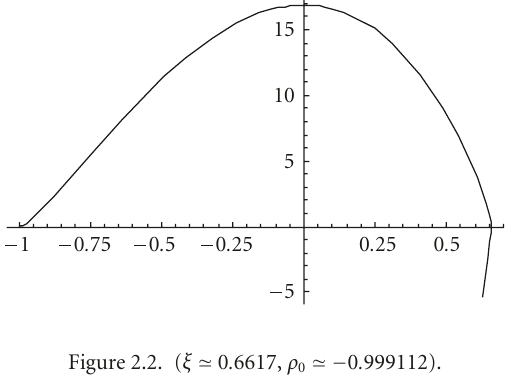
Figure 2.2. ( ξ (cid:8) 0 . 6617, ρ 0 (cid:8) − 0 . 999112).